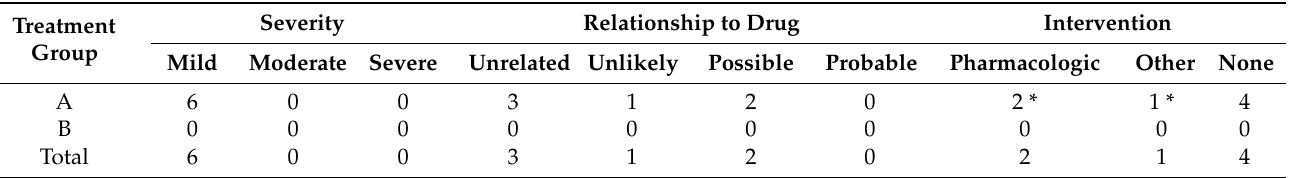
Table 7. Severity, relationship to study and action taken for adverse